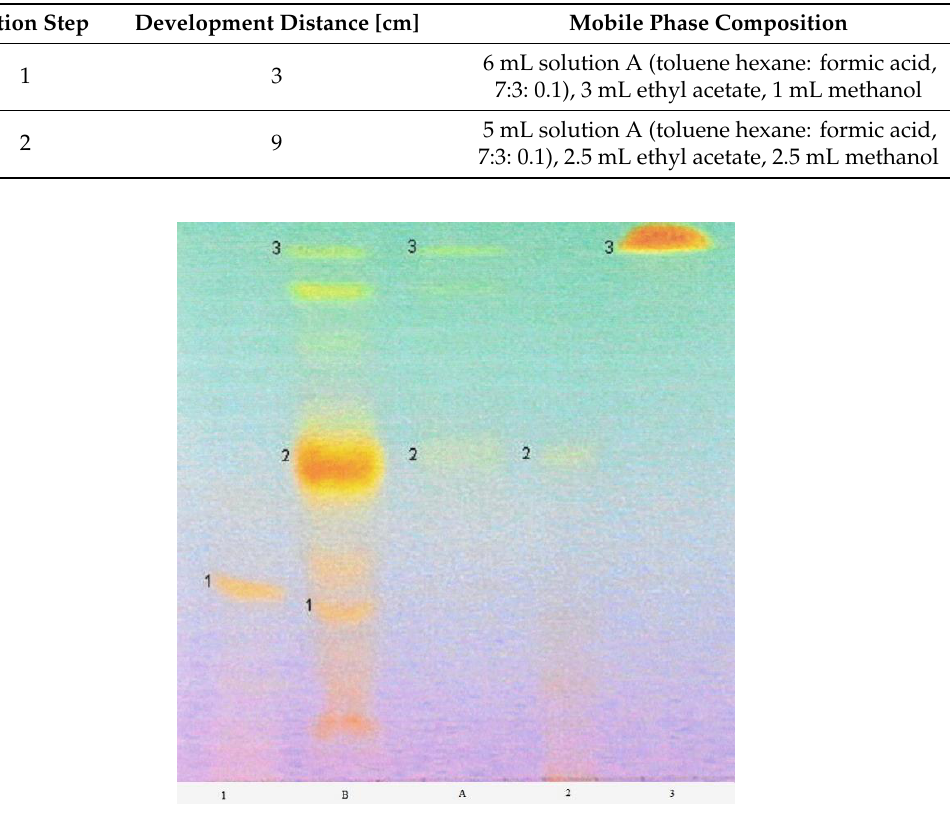
Figure 8. Separation of phenolic acids in methanol extracts of L. album subsp. album flowers. A —ethyl acetate extract-excluded from the investigations; B —methanol extract; C —acid hydrolysis; D —basic hydrolysis; MW —mixture of standards; 2—protocatechuic acid (3,4-dihydroxybenzoic); 3—vanillic acid